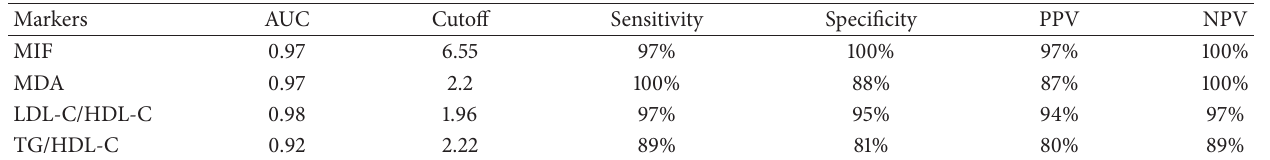
Table 4: Diagnostic accuracy of potential predictors of diabetic